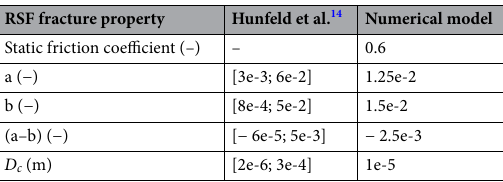
Table 2. Rate-and-state parameters measured on Slochteren sandstone samples by Hunfeld et al. 14 and the parameter values used in our